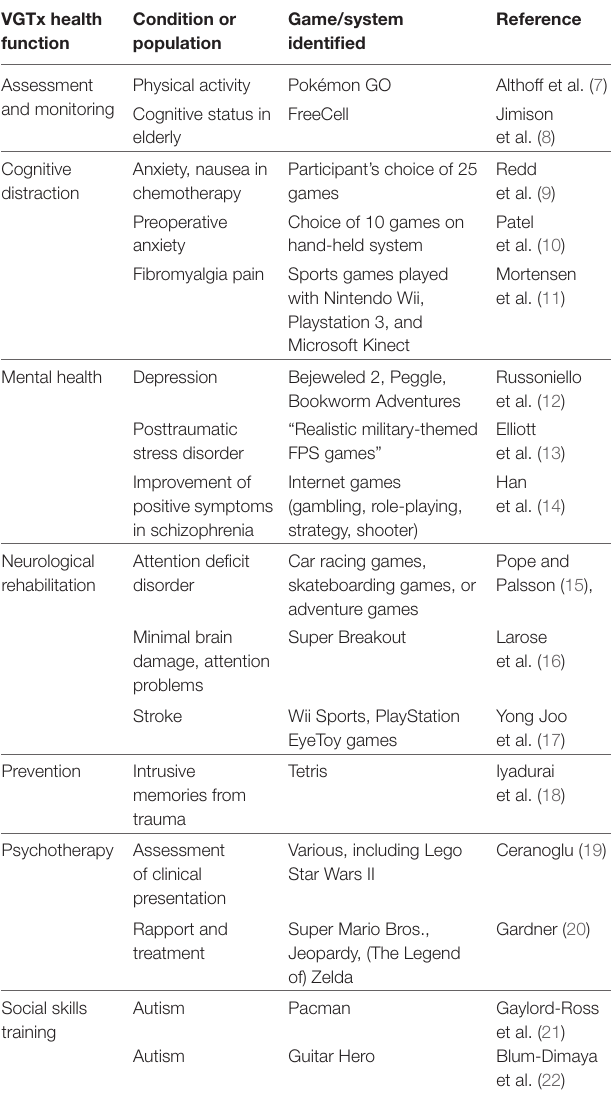
TABLe 1 | Selected studies of video games and health